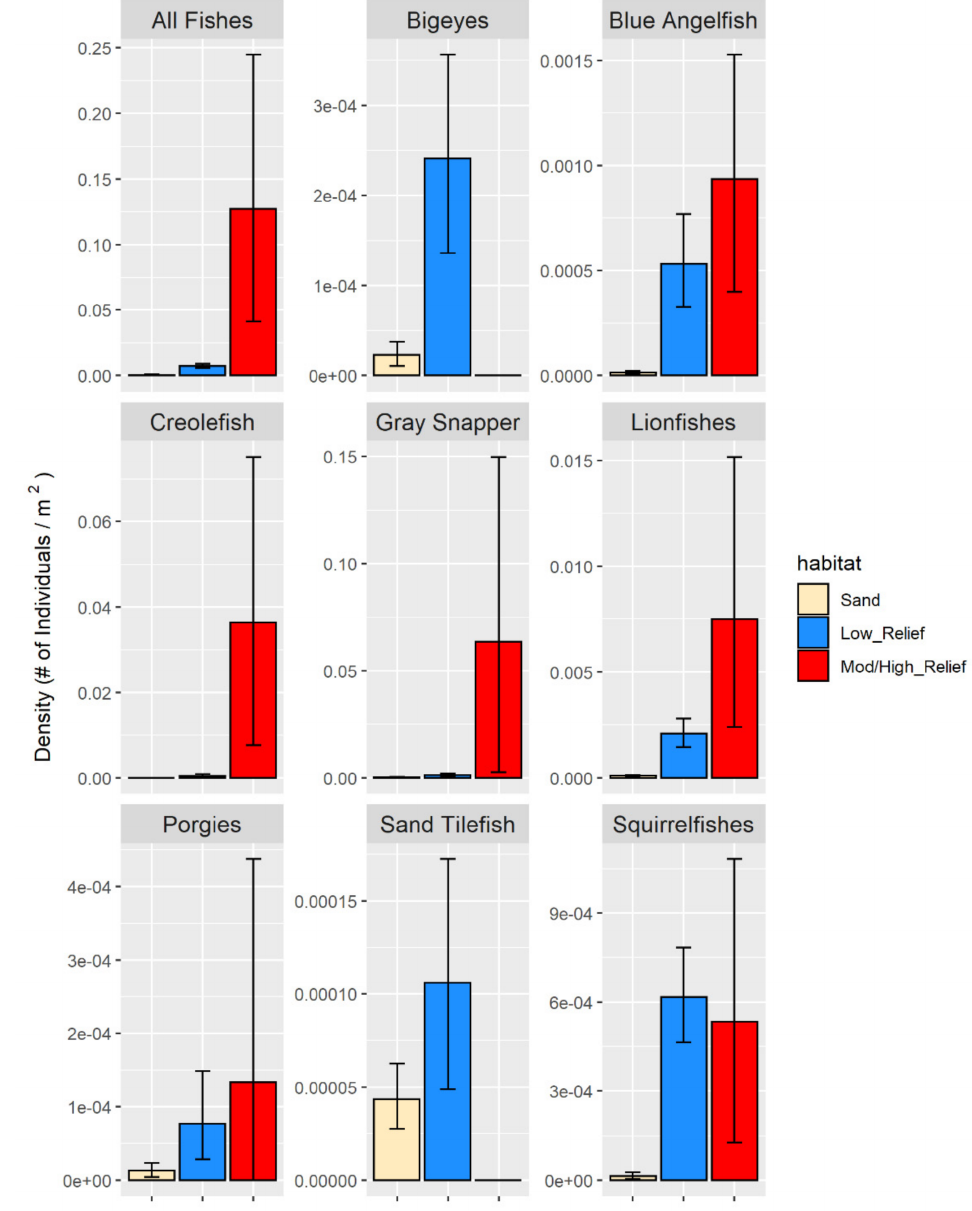
Figure 13. The habitat-specific densities for select fish taxa by habitat type determined from the towed video transects. Error bars represent the 95% bootstrap confidence